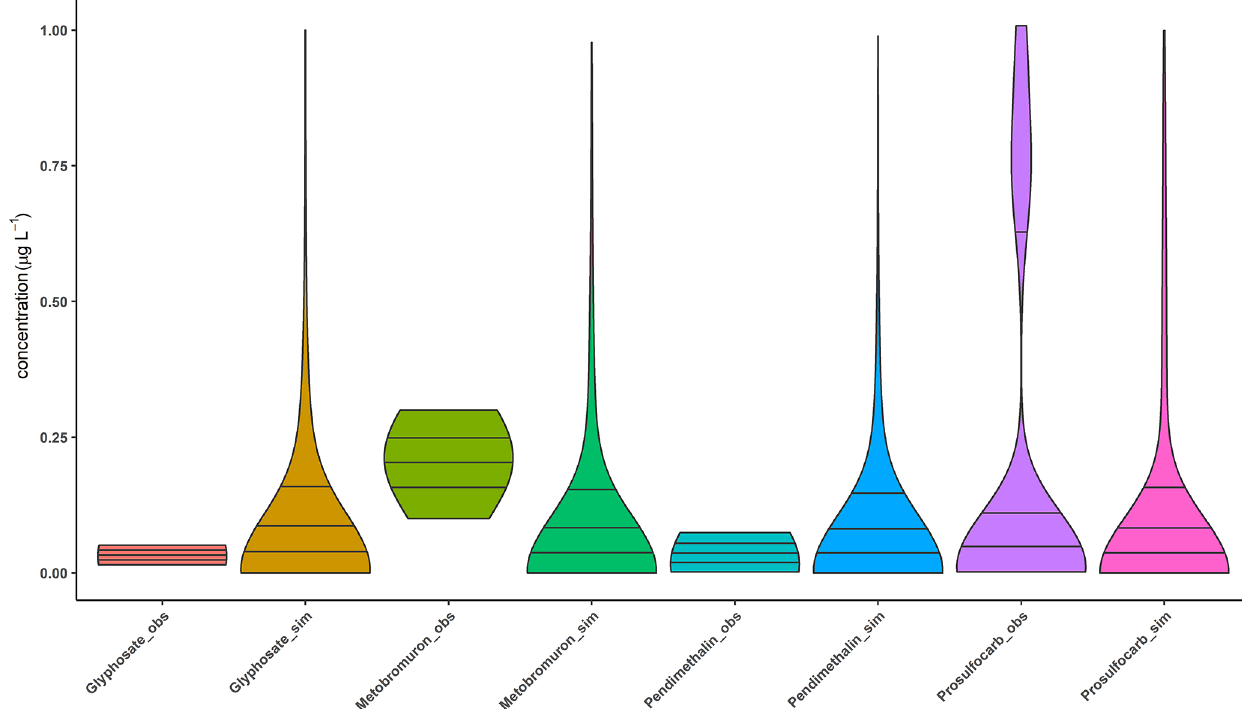
Figure 10. Violin plots showing the probability density distribution and three quartiles (25th, 50th, and 75th) of simulated ( N = 10000 iterations) vs. observed (glyphosate N = 20, metobromuron N = 8, pendimethalin N = 73, and prosulfocarb N = 25) concentrations for four active